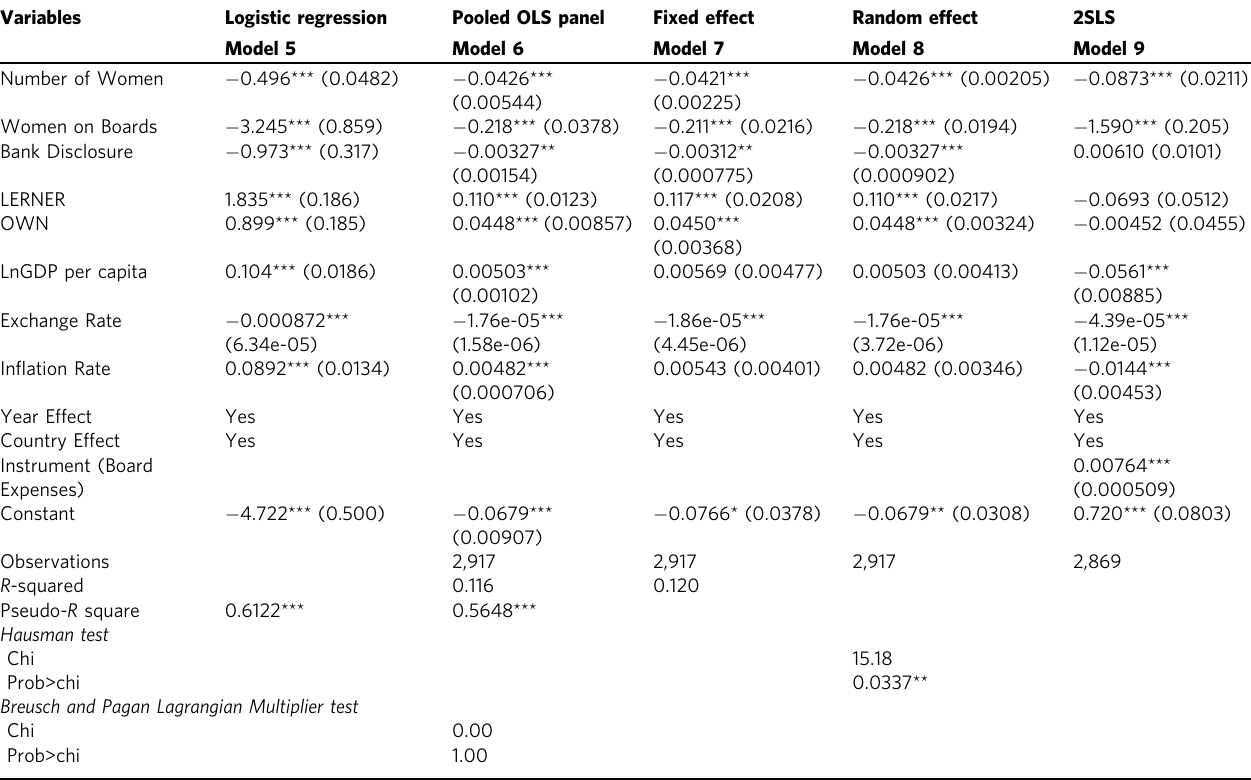
Table 5 Robust checks: Independent effect of board gender diversity and bank disclosure on banking